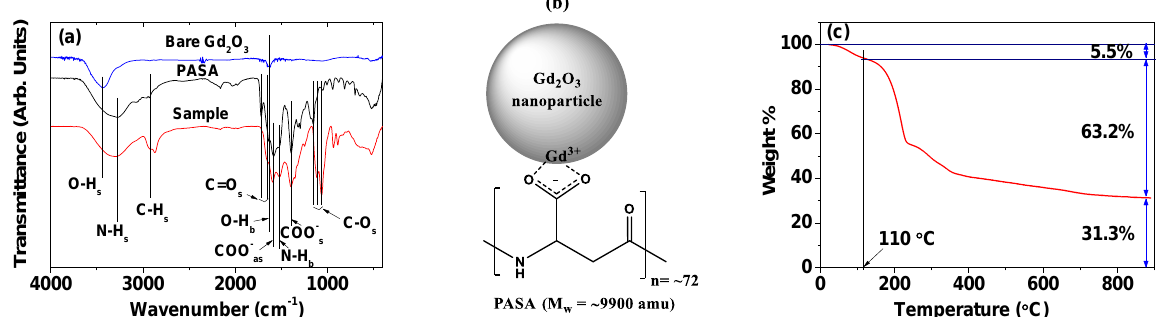
Figure 5. ( a ) FT-IR absorption spectra of bare Gd 2 O 3 , PASA, and sample (i.e., PASA-coated Gd 2 O 3 nanoparticles): Subscripts s, as, and b indicate stretch, antisymmetric stretch, and bend, respectively. ( b ) Bonding structure of a PASA with a Gd 2 O 3 nanoparticle. Only one bridge bond is shown, but numerous bridge bonds are expected per PASA with a nanoparticle and approximately four PASA are bonded to a nanoparticle. ( c ) TGA curve of PASA-coated Gd 2 O 3 nanoparticles. The coating amount of PASA polymers per nanoparticle was estimated in weight percentage (%) from a TGA curve (Figure 5c). The initial mass drop of 5.5% between room temperature and ~110 °C was due to water desorption, and the next mass drop of 63.2% was due to PASA burning through its reaction with flowing hot air. The final mass drop of 31.3% was due to the remaining Gd 2 O 3 nanoparticles. To estimate the average number of PASA polymers coating a nanoparticle per unit surface area, a grafting den- sity ( ) [26] was calculated to be 0.29 nm −2 using a molecular mass of PASA (i.e., 9900 amu), the average particle diameter estimated from HRTEM (i.e., 2.0 nm), and the bulk density of 7.407 g/cm 3 [27] for Gd 2 O 3 . By multiplying with the average nanoparticle surface area (= πd avg2 ), the average number of PASA polymers coating a nanoparticle was estimated to be ~4. The results are provided in Table 1. 3.3. In Vitro Cell Viability As free Gd 3+ ions are toxic in vivo [28,29], in vitro cytotoxicity of PASA-coated Gd 2 O 3 nanoparticles was measured in DU145 and NCTC1469 cells. As shown in Figure 6, cell viabilities were approximately 100 and 77% in DU145 and NCTC1469 cells at 500 μM Gd, respectively, indicating good biocompatibility of the nanoparticles. 020406080 100120 C e ll V i a b ili t y Concentration (Gd) ( M) DU145 NCTC1469 0 500 Figure 6. In vitro cell viabilities of PASA-coated Gd 2 O 3 nanoparticles in DU145 and NCTC1469 cells up to 500 μM Gd. 3.4. Magnetic Properties Magnetic properties of PASA-coated Gd 2 O 3 nanoparticles were characterized by obtaining an M−H curve at T = 300 K. As shown in Figure 7, the M−H curve showed no hysteresis (i.e., zero value in coercivity and remanence), indicating paramagnetism of the nanoparticles, similar to bulk Gd 2 O 3 [30,31]. In the plot, the net M value of the nanopar- ticles (i.e., only Gd 2 O 3 nanoparticles without PASA) was used, which was estimated us-